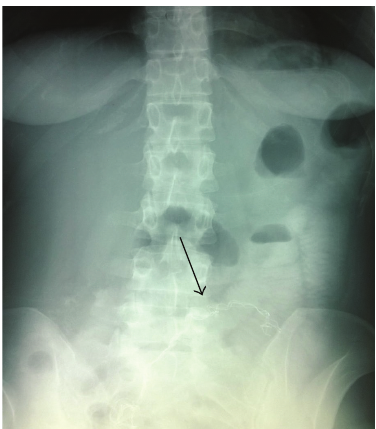
Figure 2: Plain abdominal radiograph revealing a gauze in abdom- inal